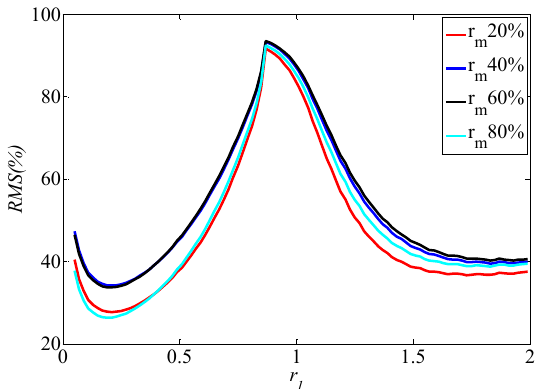
Figure 6. E ff ect of length on control e ff ectiveness: curves of RMS . Figure 6. Effect of length on control effectiveness: curves of RMS .